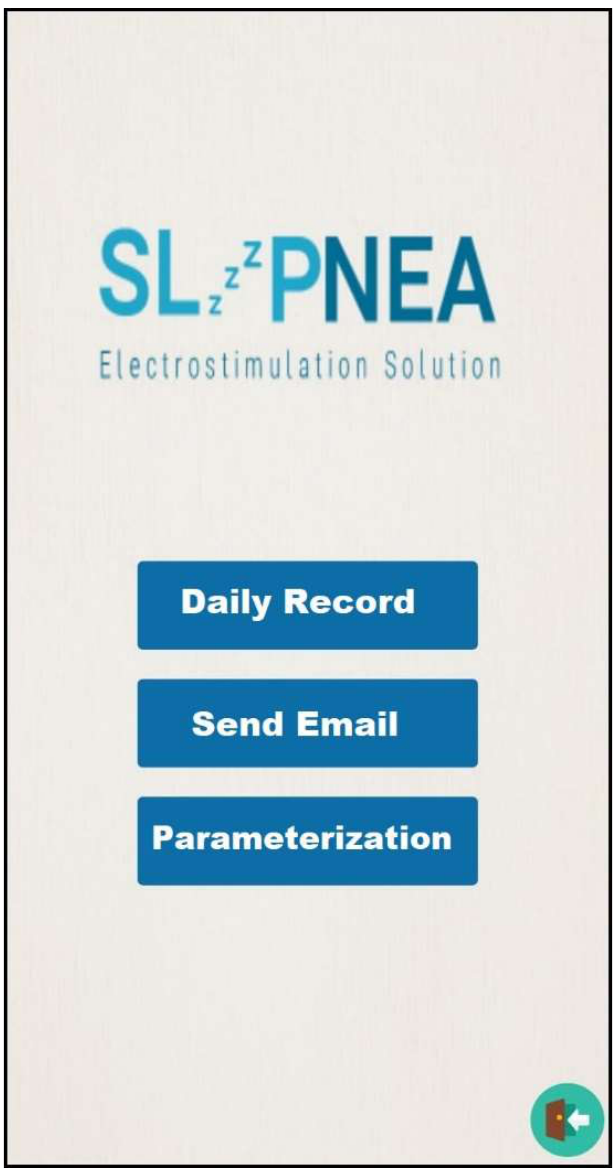
Figure 12. mHealth application start